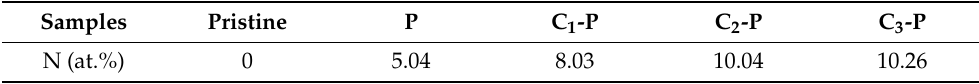
Table 2. Atomic content of surface N element for different samples.